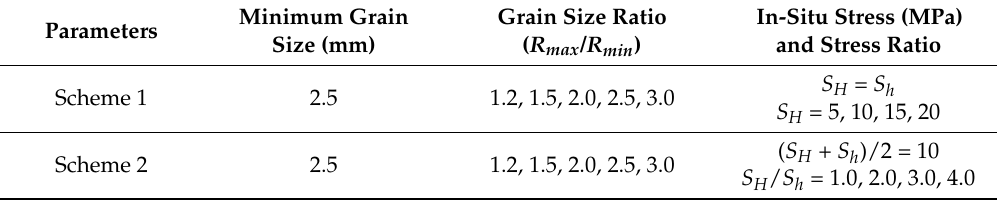
Table 2. Scenarios with heterogeneous grain sizes and different in-situ stress